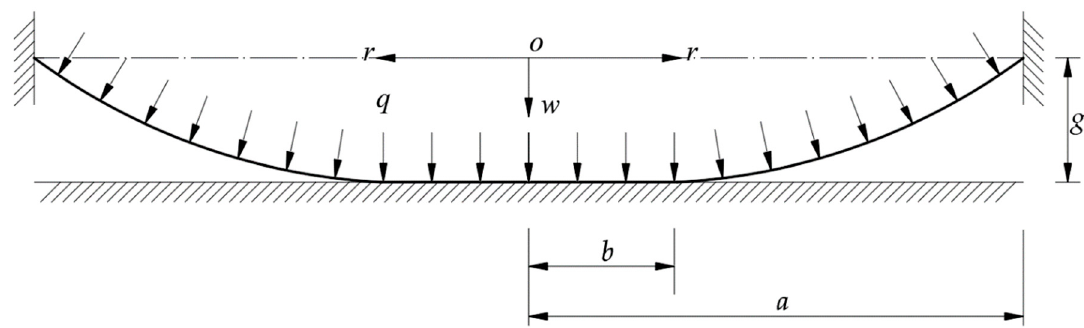
Figure 1. Sketch of the deformed circular membrane in contact with the frictionless rigid plate.